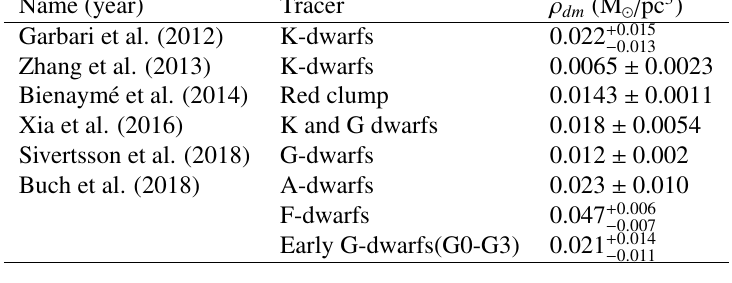
Table 1. Several determinations of the local dark matter density for the recent years.